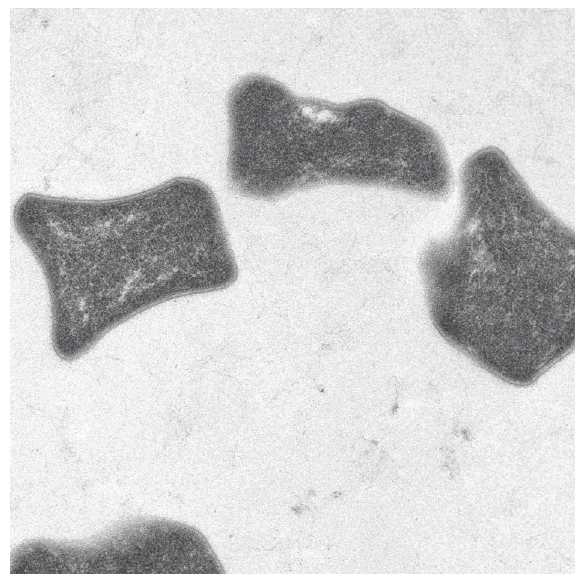
Figure 1: Sulfolobus solfataricus cells. Courtesy of Mark